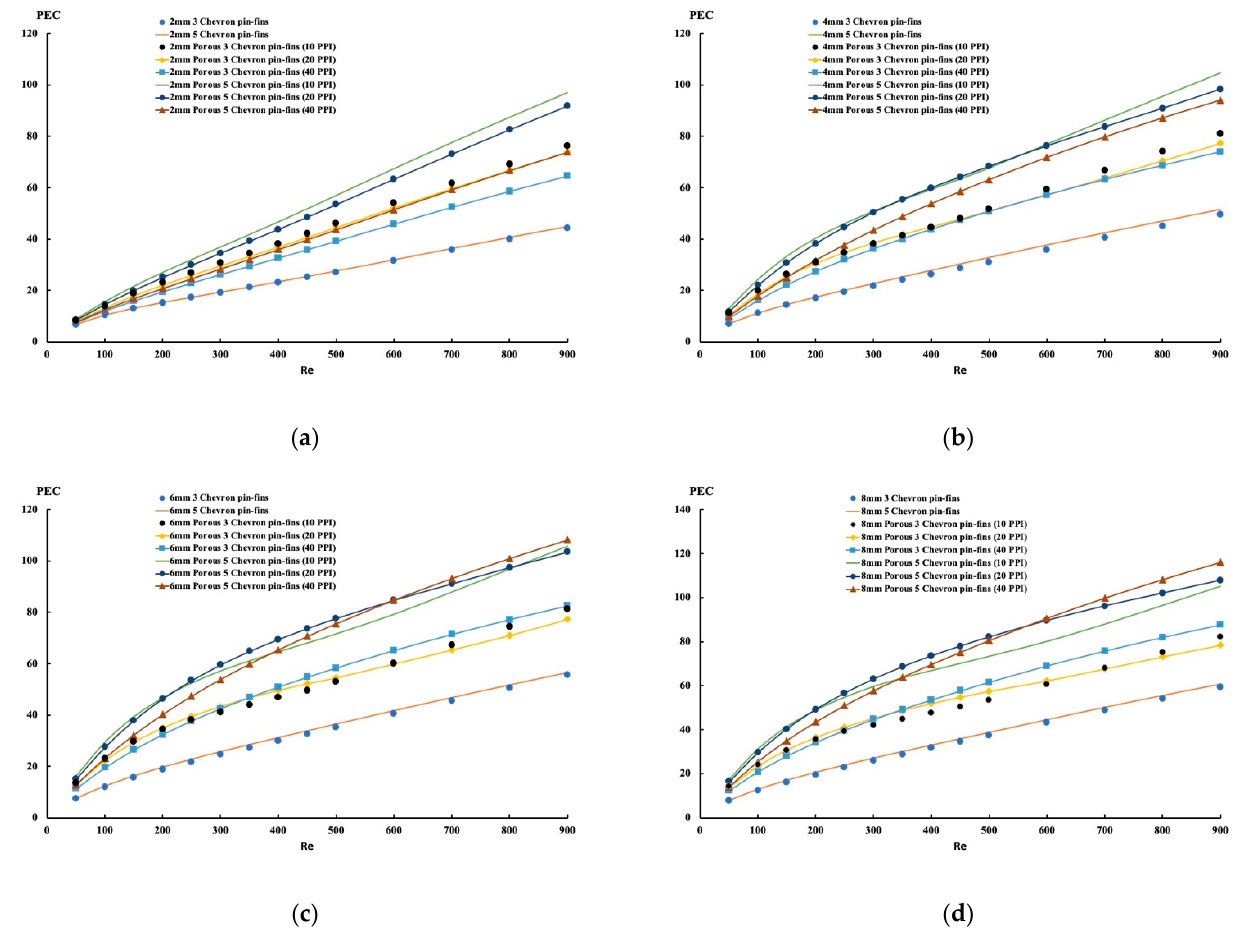
Figure 11. PEC variation for all cases: ( a ) 2 mm pin-fin height; ( b ) 4 mm pin-fin height; ( c ) 6 mm pin-fin height; ( d ) 8 mm pin-fin height.